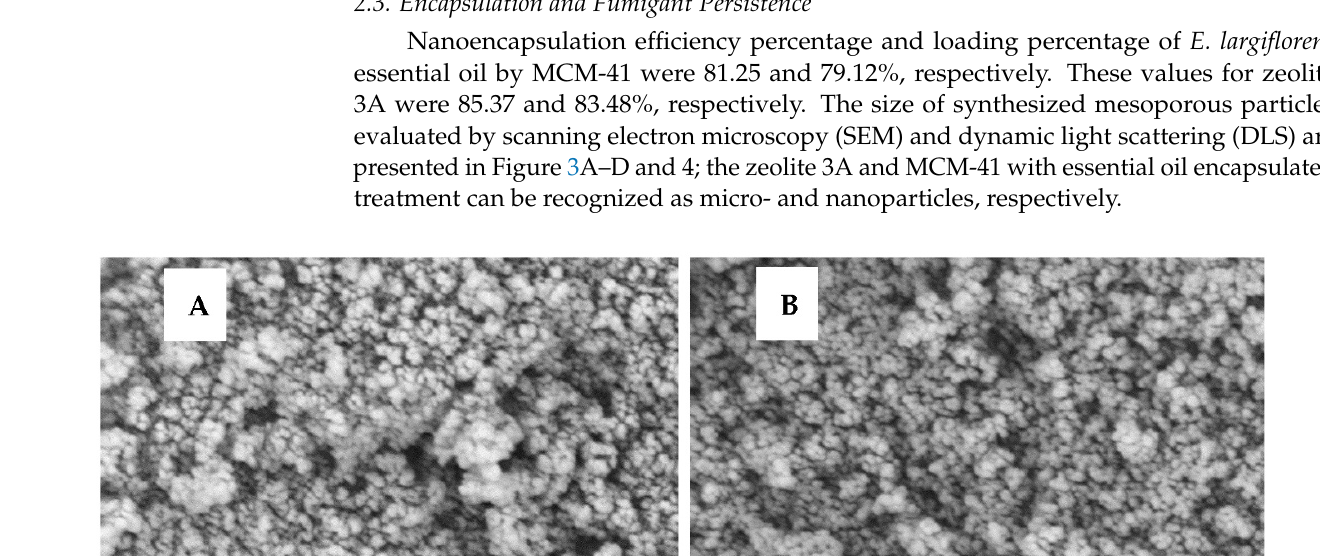
oil; ( C ): zeolite 3A; ( D ): zeolite 3A-essential oil).